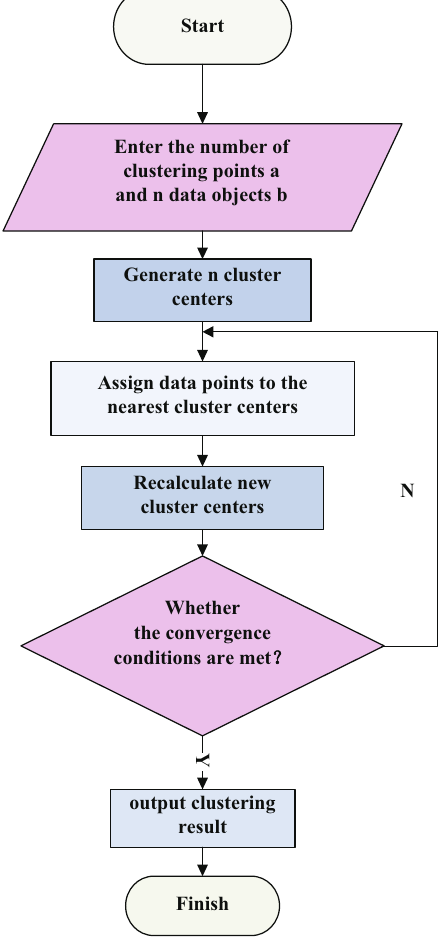
Figure 4: K - means spatial data clustering algorithm fl